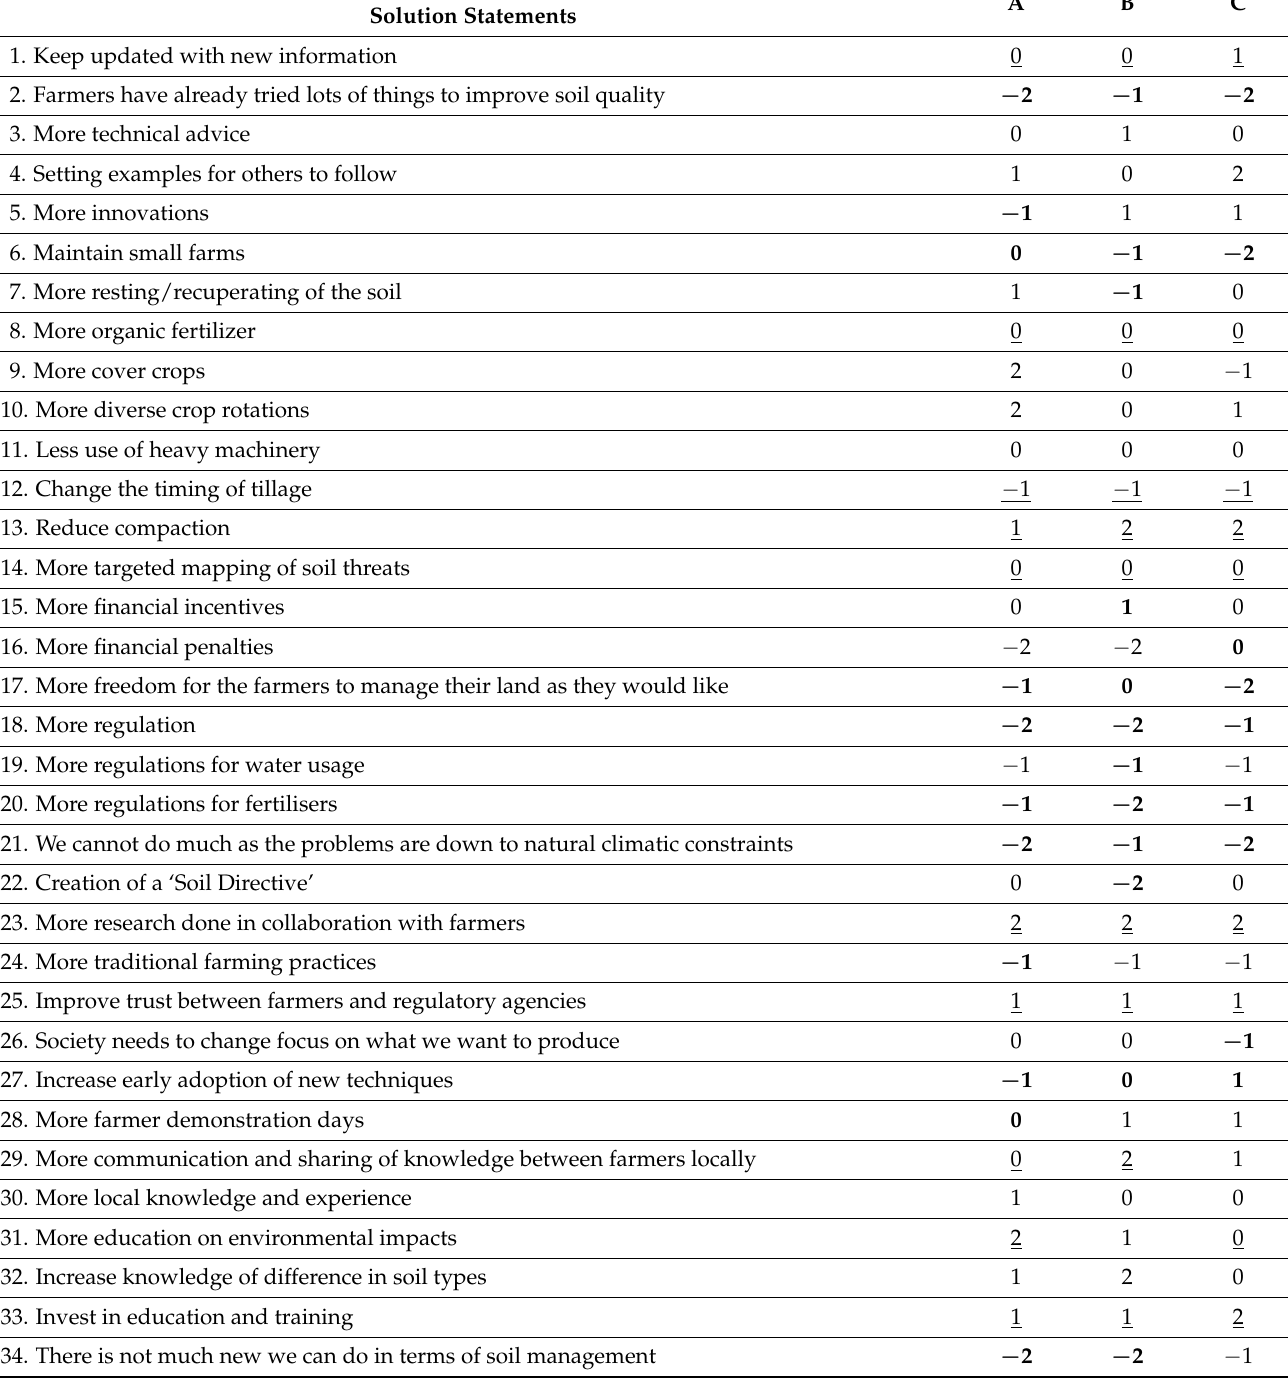
Table A3. Average Q-sort scores for each of the four factors identified as solutions to improve soil by UK respondents. Bold text indicates distinguishing statement at p < 0.01, underlined text indicates consensus statements; scale from − 2 (strongly disagree) to 2 (strongly